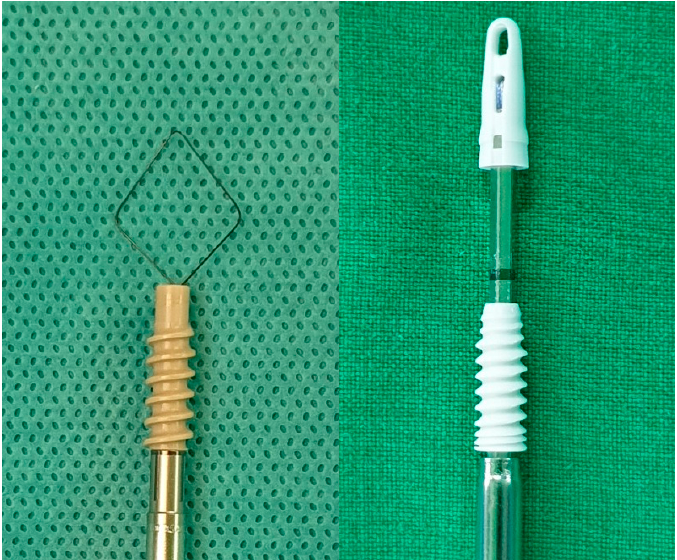
Figure 1. The anchors utilized in the current study have the same 4.75 mm diameters. The 4.75 mm CrossFT™ knotless anchor (left: ConMed, Utica, NY, USA) and 4.75 mm Fix2Lock™ anchor (right: Kinex Osteonic, Seoul, Korea) are shown.